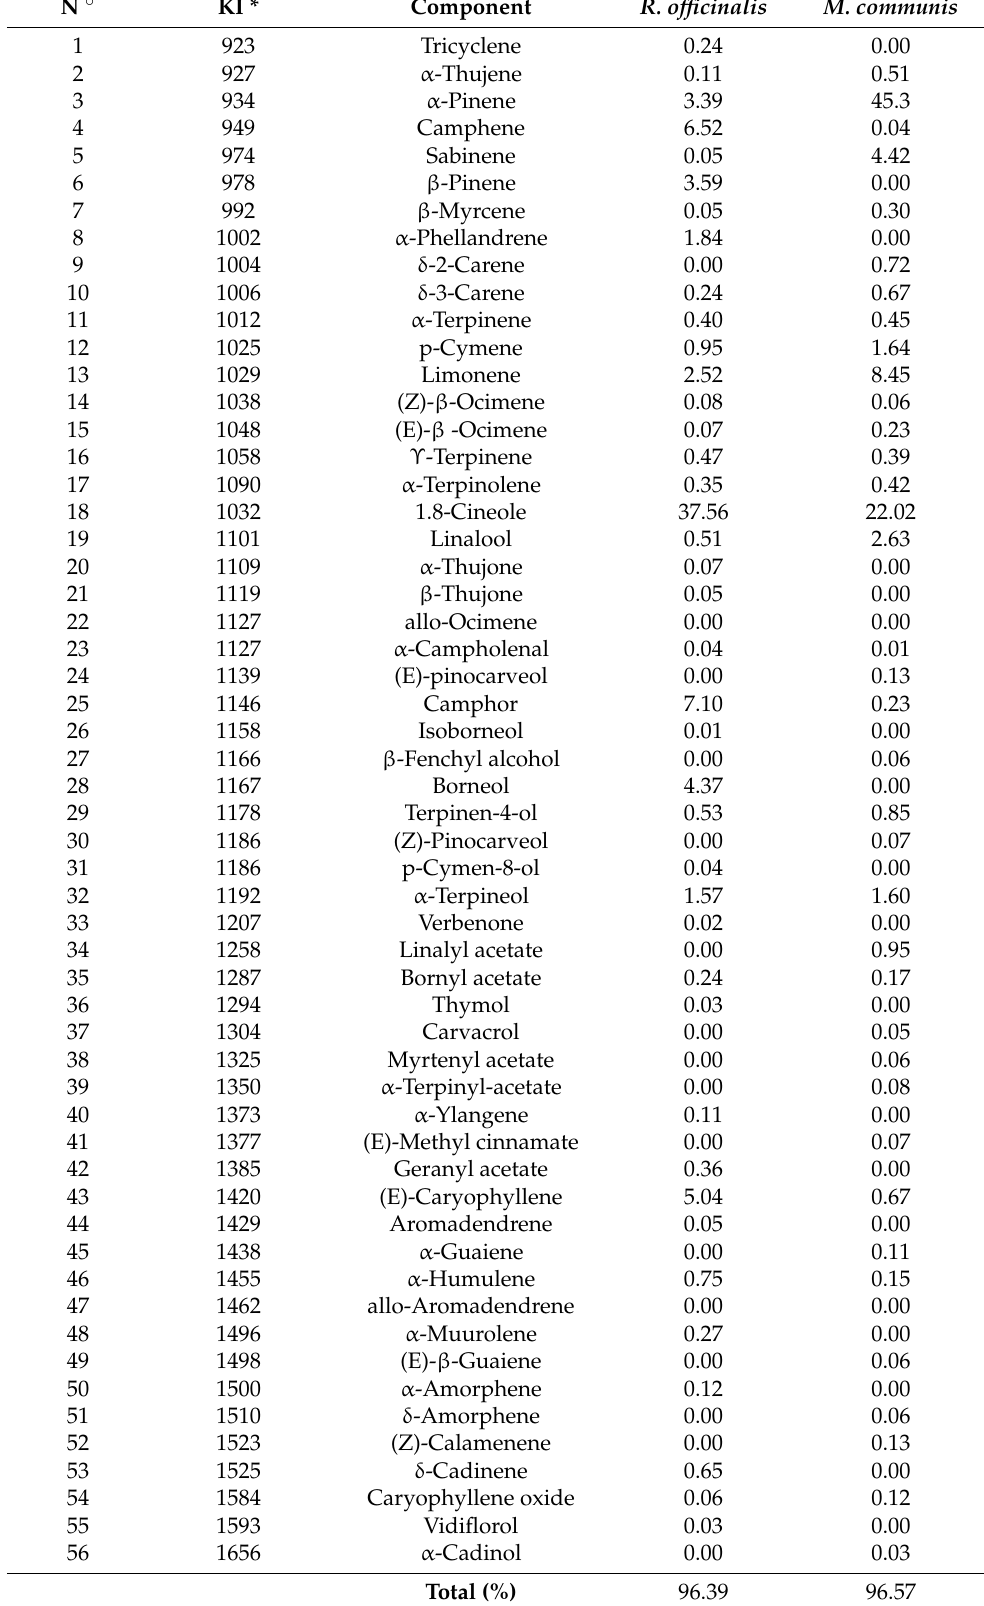
Table 1. Chemical composition (%) of R . officinalis and M. communis essential